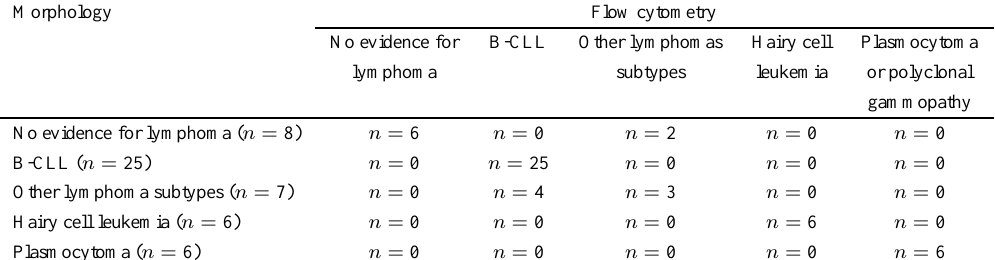
Illustration of the results obtained by flow cytometry and knowledge guided cluster analysis in comparison to morpholo-